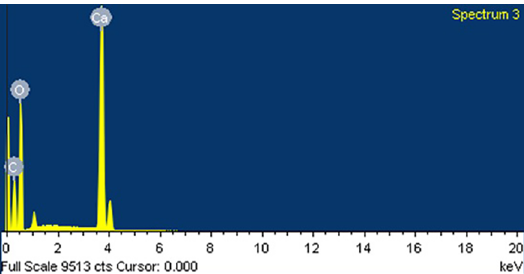
at 400°C Figure 6. EDX spectral data for CaCO 3 show that the dielectric constant decreases as the applied frequency increases. As might be expected from the bulk ceramic data, the trigonal (isometric 32/m) powder shows a much smaller value of ε . This is because the polarization r contribution is maximized due to many coexisting dipole moments at these voltages. In Figure 7, LC resonances are seen on the dielectric constant as a function of driven